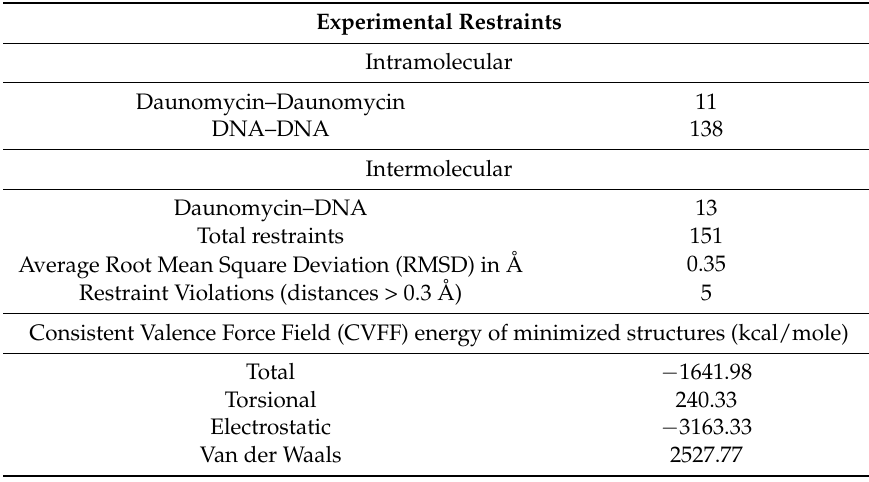
Figure 7. Energy minimized model of daunomycin bound to [d-(TTGGGGT)] 4 obtained by restrained molecular dynamics simulations; ( a ) Binding of daunomycin at two independent sites T1pT2 and G6pT7; ( b , c ) Close-up view of daunomycin binding to [d-(TTGGGGT)] 4 at the T1pT2 site; and ( d , e ) At G6pT7 site (hydrogen bond is represented by black dashed line). Table 4. Structural data and final energy terms of daunomycin-[d-(TTGGGGT)] 4 complex. Experimental Restraints